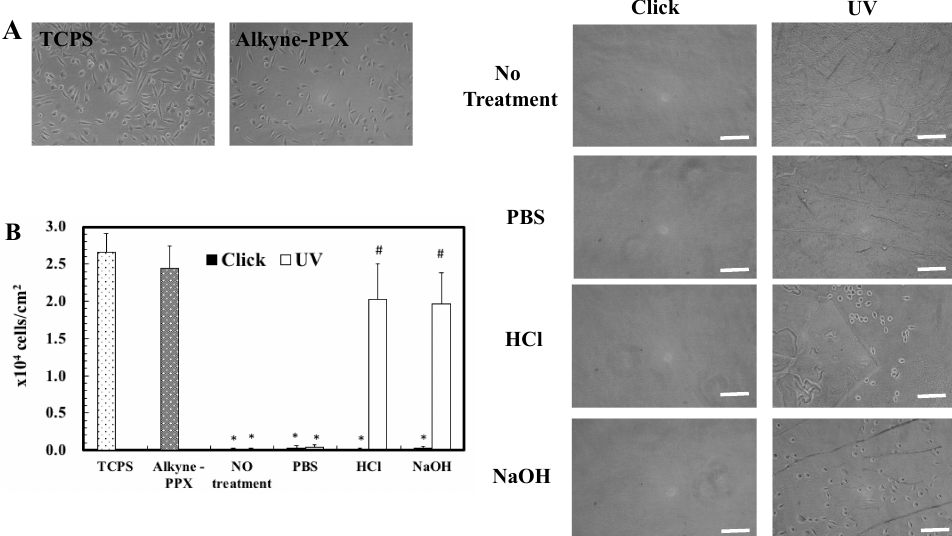
Figure 3. Stability of pSBAz coatings in PBS, 1 N HCl, or 1N NaOH. TCPS was first deposited with Alkyne-PPX, and then cross-linked with pSBAz via click chemistry or UV irradiation. The modified surfaces of pSBAz were incubated in PBS, 1 N HCl, or 1 N NaOH for 24 h. The adhesion of L929 cells was allowed on various surfaces for 6 h. ( A ) Representative microscopic images of cell adhesion on various substrates. Scale bar = 100 μ m. ( B ) Quantified data of cell adhesion. Value = mean ± standard deviation, n = 5. * Represent p < 0.001, compared to the cell adhesion to Alkyne-PPX; # p < 0.001, compared to the cell adhesion to the corresponding Click.